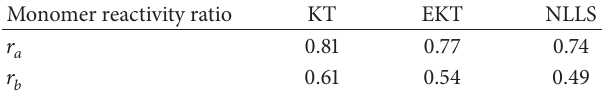
Table 4: The reactivity ratios calculated by the three methods.